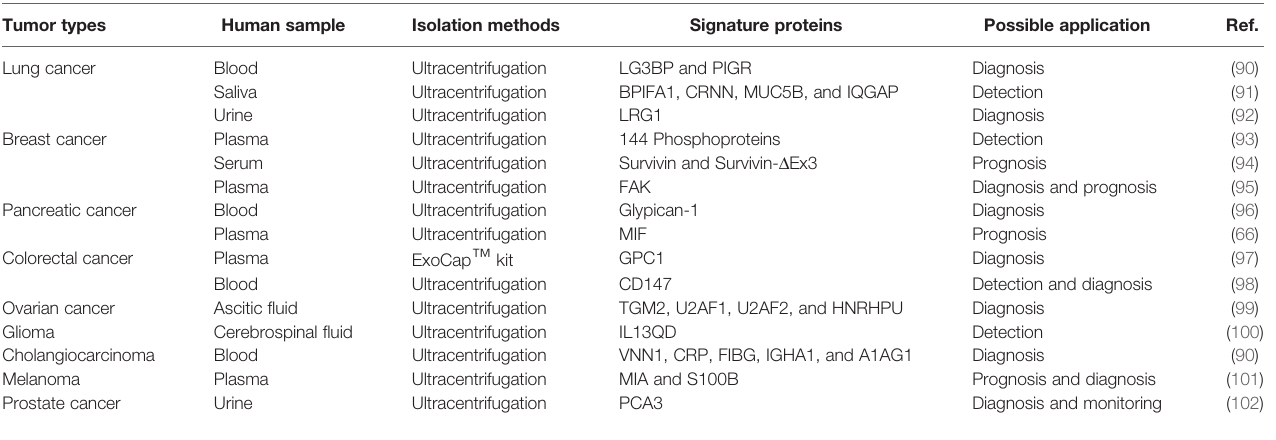
TABLE 1 | sEV protein markers in multiple